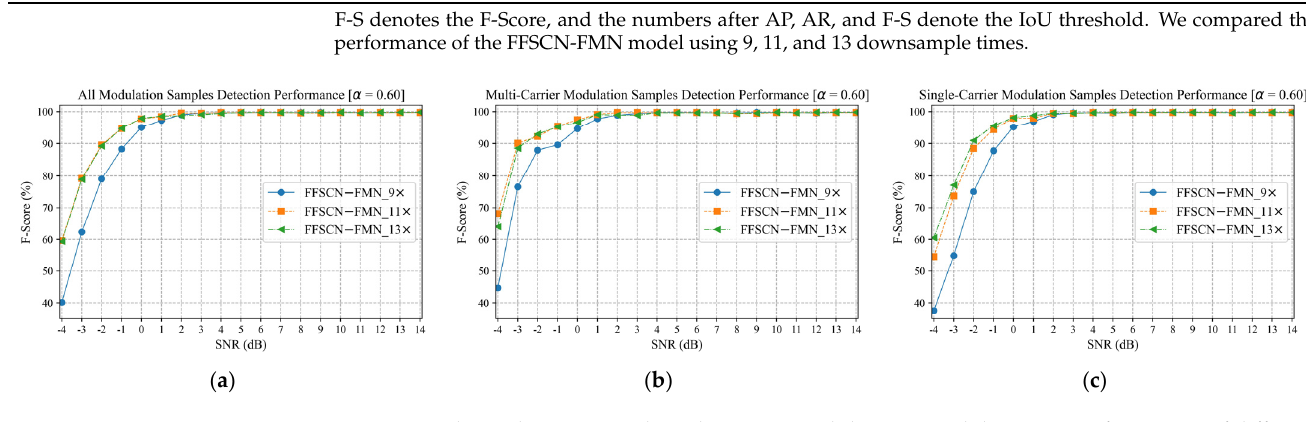
( c ) Figure 9. Effects of the two different adaptive pooling layer types used in the FFSCN models: ( a ) FFSCN-FMN; ( b ) FFSCN-MN; ( c ) FFSCN-R. Here, α denotes the IoU threshold, and we fixed it to 0.6. 4.5.2. Impact of Downsample Times In Table 5, we show the performance comparison of different downsample times used in the FFSCN-FMN model. We can see that FFSCN-FMN_11 × achieved the best AR and F-Score and that FFSCN-FMN_13 × achieved the best AP, but the increase was feeble compared to FFSCN-FMN_11 × . Furthermore, the multi-carrier and single-carrier modu- lation signal detection performances of different downsample times in the FFSCN-FMN